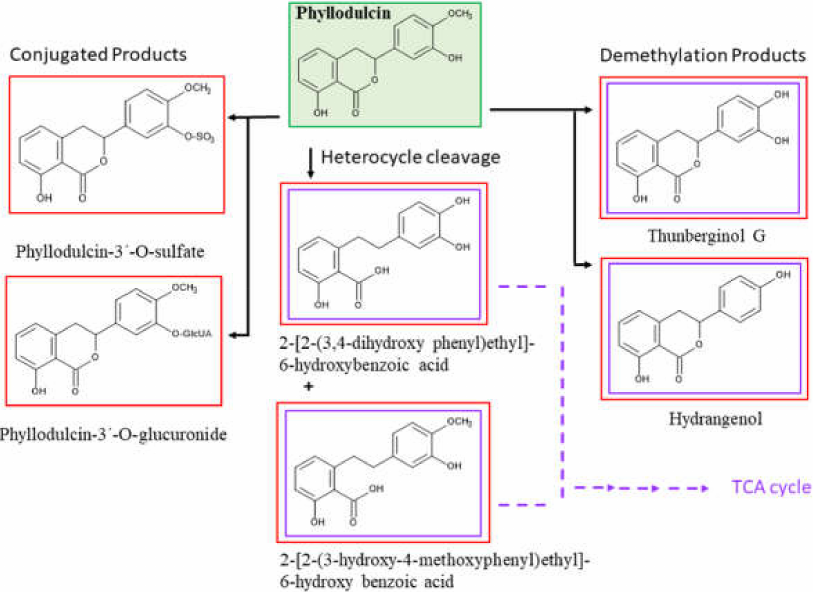
Figure 6. Detoxification and degradation of phyllodulcin in mammals (red outlines/black arrows) and breakdown of the aromatic ring system by bacteria (purple outlines/lines/arrows; dashed line: hypothetical). Green outlines/box: plant originated